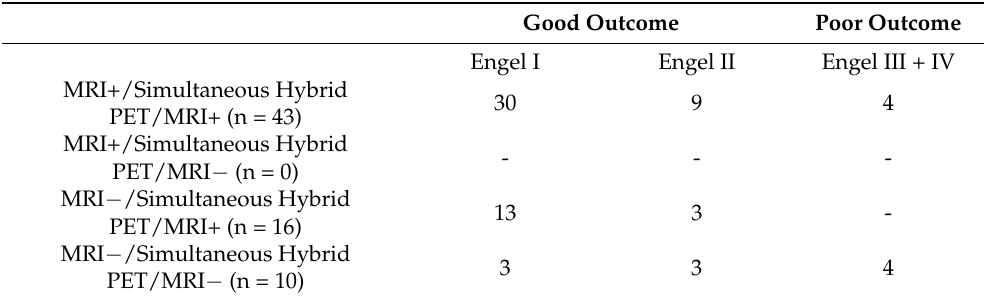
Table 5. Comparison of four groups (MRI+/Simultaneous Hybrid PET/MRI+, MRI+/Simultaneous Hybrid PET/MRI − , MRI-/Simultaneous Hybrid PET/MRI+, MRI − /Simultaneous Hybrid PET/MRI − ) based on outcomes. Good Outcome Poor Outcome Engel I Engel II Engel III + IV MRI+/Simultaneous Hybrid 30 9 4 PET/MRI+ (n = 43) MRI+/Simultaneous Hybrid - - - PET/MRI − (n = 0) MRI − /Simultaneous Hybrid 13 3 - PET/MRI+ (n = 16) MRI − /Simultaneous Hybrid 3 PET/MRI − (n = 10)